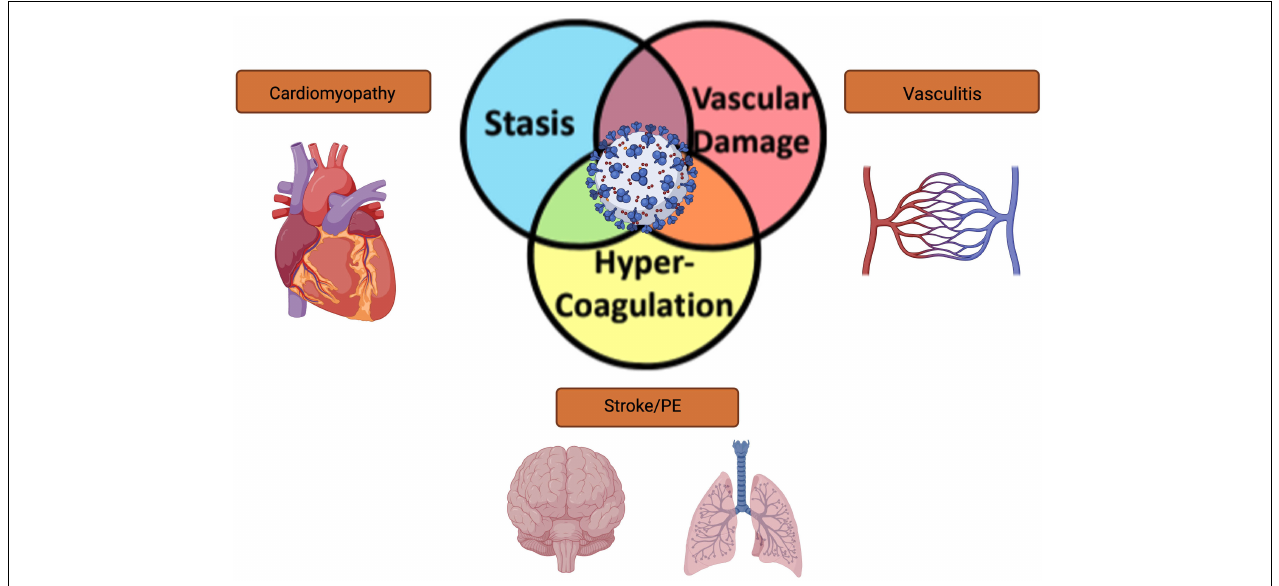
FIGURE 1 | Schematic representation of the overlapping limbs of Virchow’s triad and how COVID-19 affects vascular thrombosis in different organ systems.